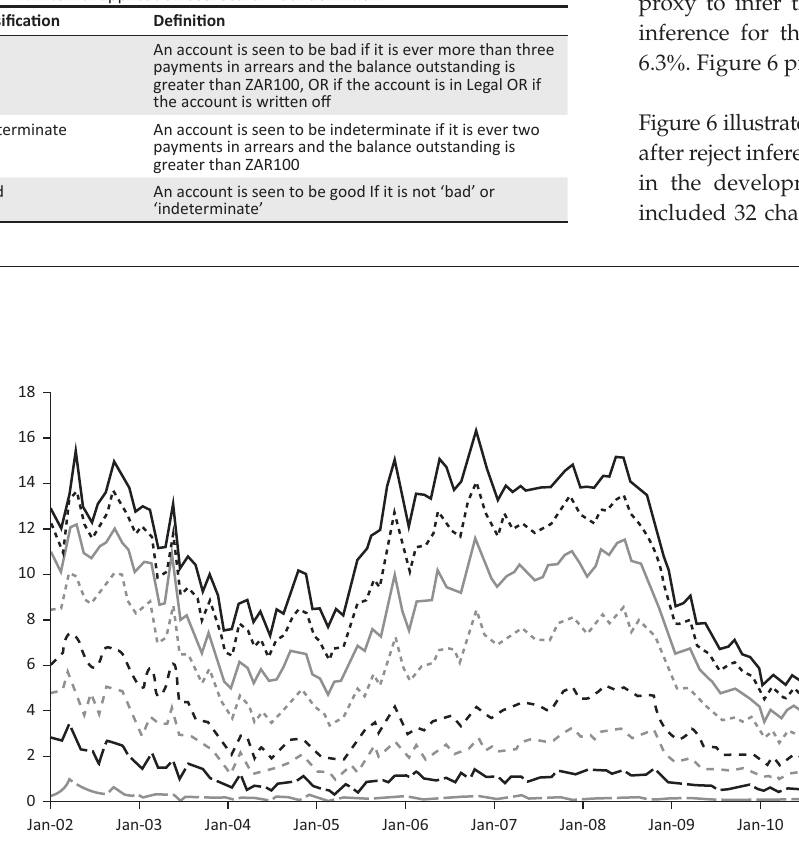
FIGURE 4: Maturity